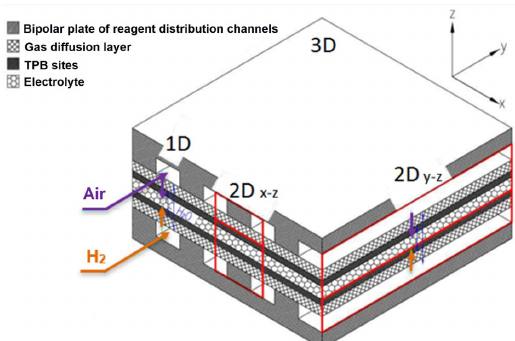
Figure 1. Modeling domains applicable in the characterization of the problem to be